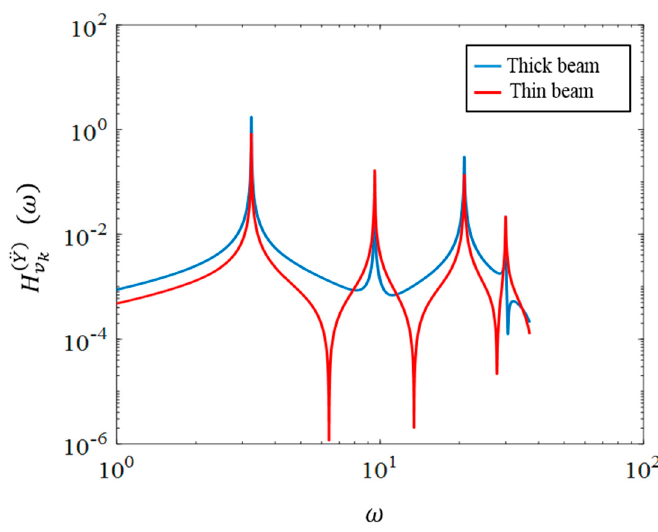
Figure 6. Frequency response curves of the normalized tip displacement of the thin and thick beams due to harmonic base acceleration.